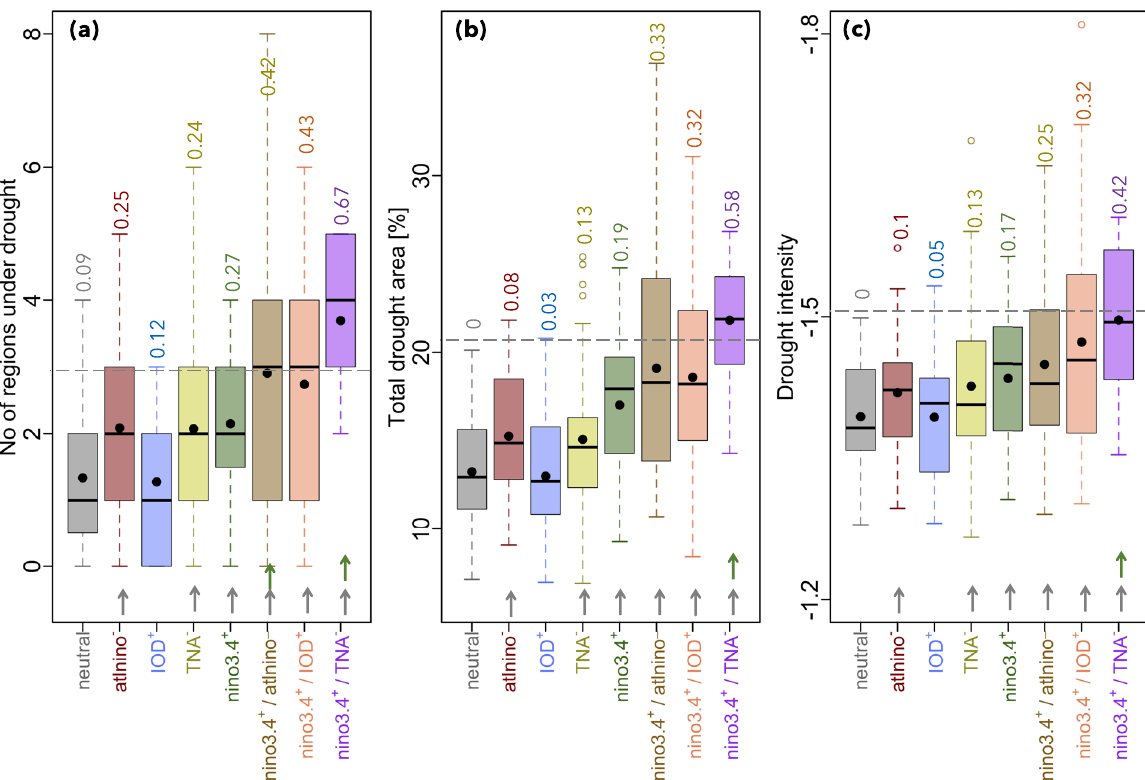
Fig. 6 In fl uence of modes of variability on compound drought characteristics. The distribution of a number of regions under drought, b drought area, and c drought intensity during seasons with individually occurring variability modes and co-occurring conditions noted below each boxplot, from the CESM preindustrial simulation. Horizontal gray solid lines indicate the thresholds used to de fi ne a compound (i.e., (cid:1) three regions under drought, gray line), b widespread (i.e., events with >90 th percentile of total area (~21%) across all ten regions concurrently affected by drought, gray line), and c severe (i.e., average SPI across all drought affected areas < 10 th percentile (~ − 1.52), gray line) droughts. Text above the boxplots in a indicates the probability of compound droughts under each condition, b indicates the probability of experiencing widespread droughts and c indicates the probability of experiencing intense droughts. For example, the probability of three or more regions concurrently affected by droughts under neutral and Niño3.4 + conditions is 0.1 and 0.41, respectively. Gray arrows indicate signi fi cant differences in the distribution of drought area and intensity corresponding to various conditions relative to neutral conditions at 5% signi fi cance level. Green arrows indicate signi fi cant differences in the distributions between the co-occurring conditions and Niño3.4 + conditions at 5% signi fi cance level. Black dots show the mean of the distribution in each